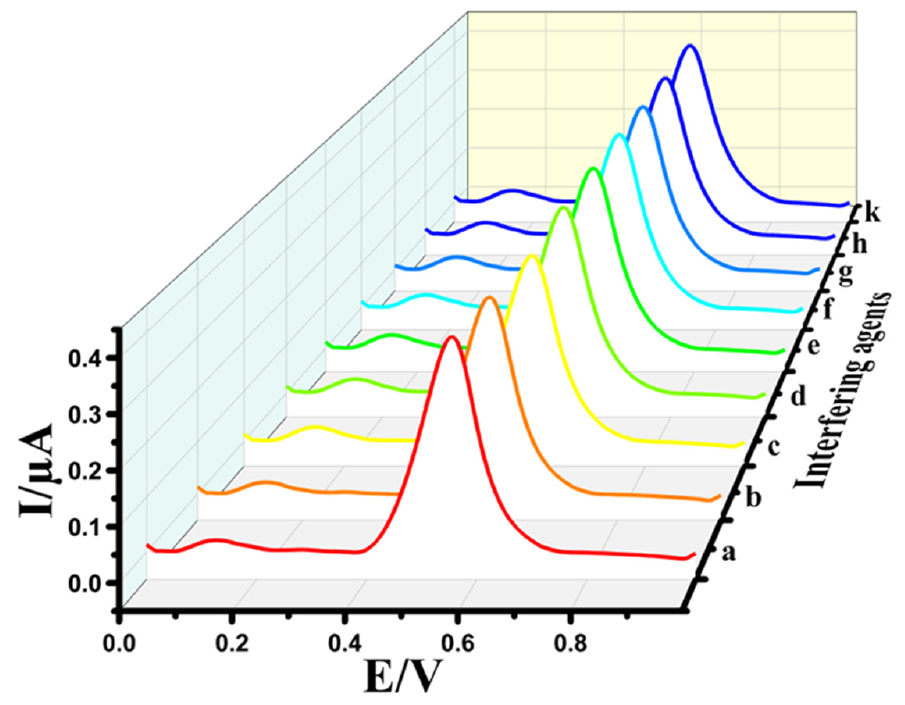
Figure 7. DPVs of 0.5 µM EPR ( a ) in the presence of various 200-fold ascorbic acid ( b ), uric acid ( c ), glucose ( d ), L-cysteine ( e ), L-arginine ( f ), dopamine ( g ), vitamin D ( h ) and vitamin B12 ( k ) at the Au@NiFe 2 O 4 /SPE.